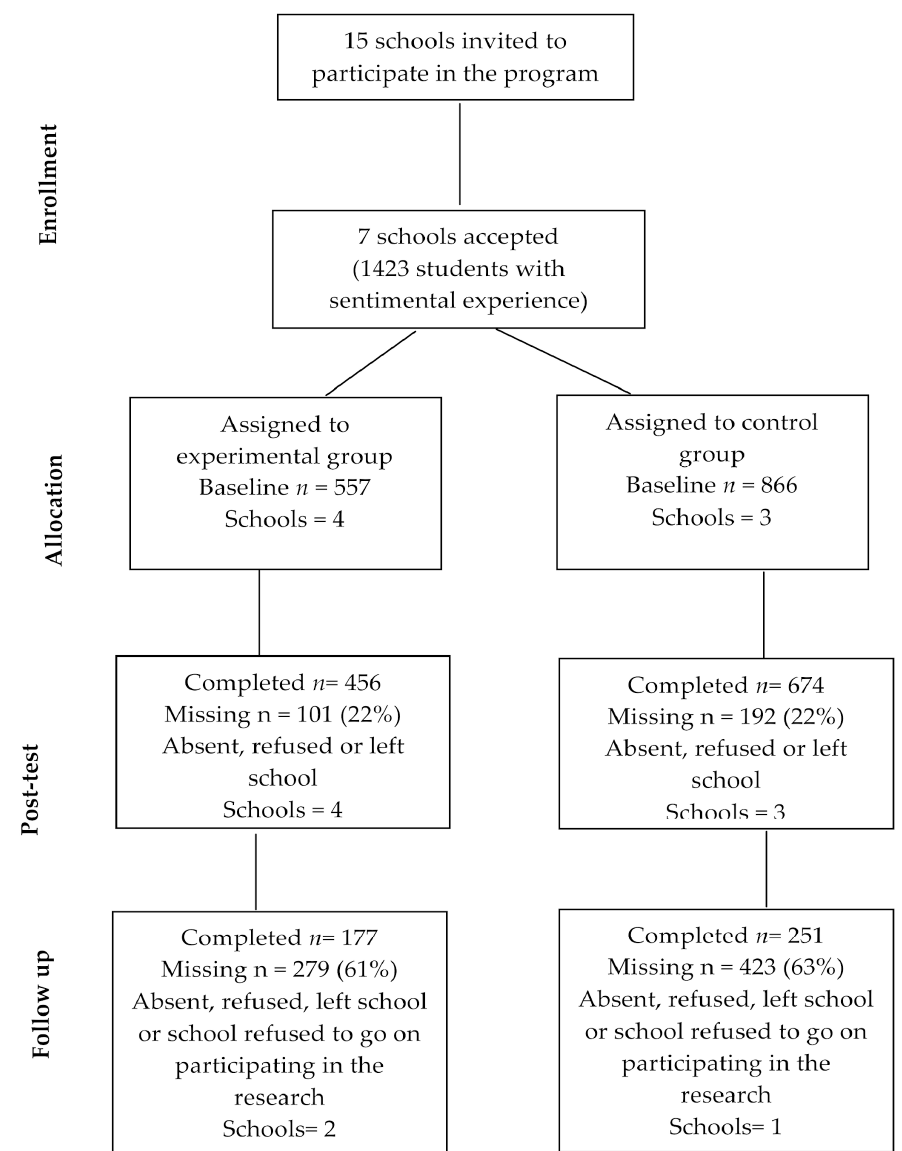
Figure 1. Flowchart of the recruitment and retention of participants in the evaluation.